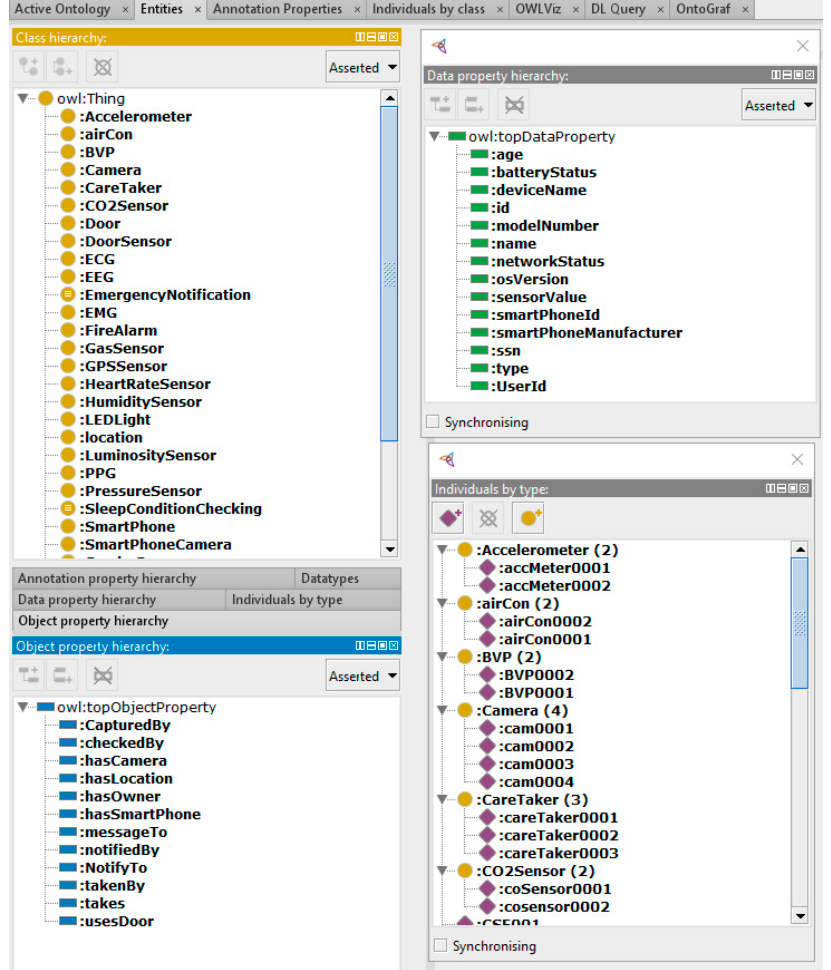
Figure 15. Views of developed ontology concepts in Protégé.